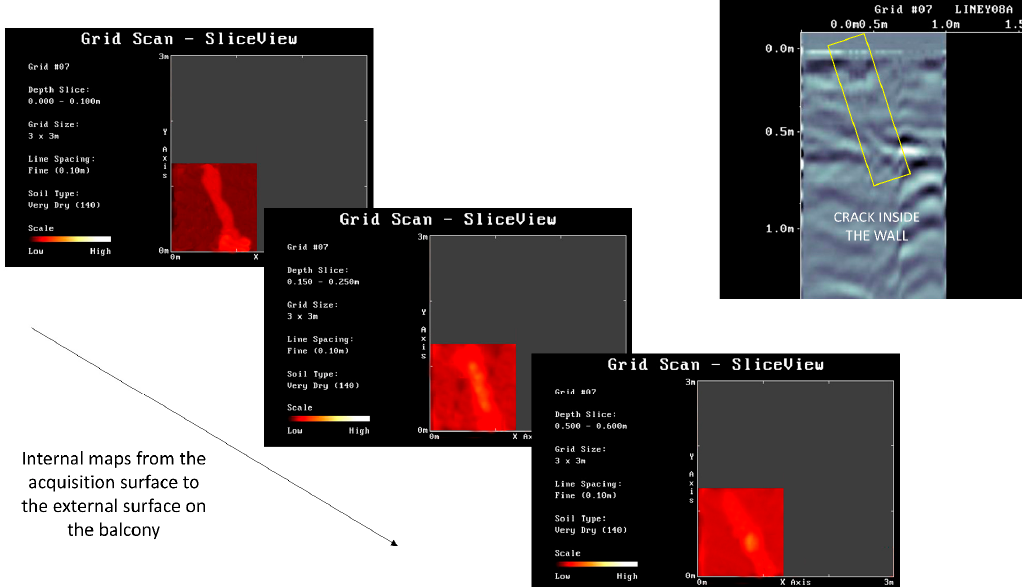
Figure 7. Both the GPR profiles (top right) and the three depth-slices show the presence of the crack and its inner geometry passing through the 0.5 m thick masonry from side to side. Geosciences 2018 , 8 , x FOR PEER REVIEW